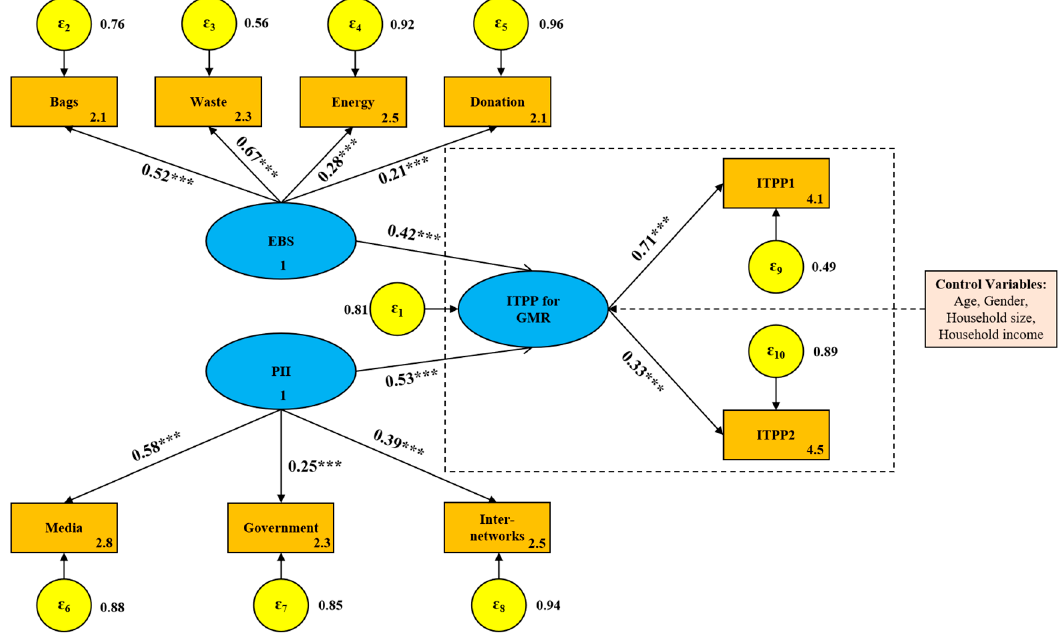
Figure 6. SPCs of the original structural model. Note: “***”, significant 1% level.